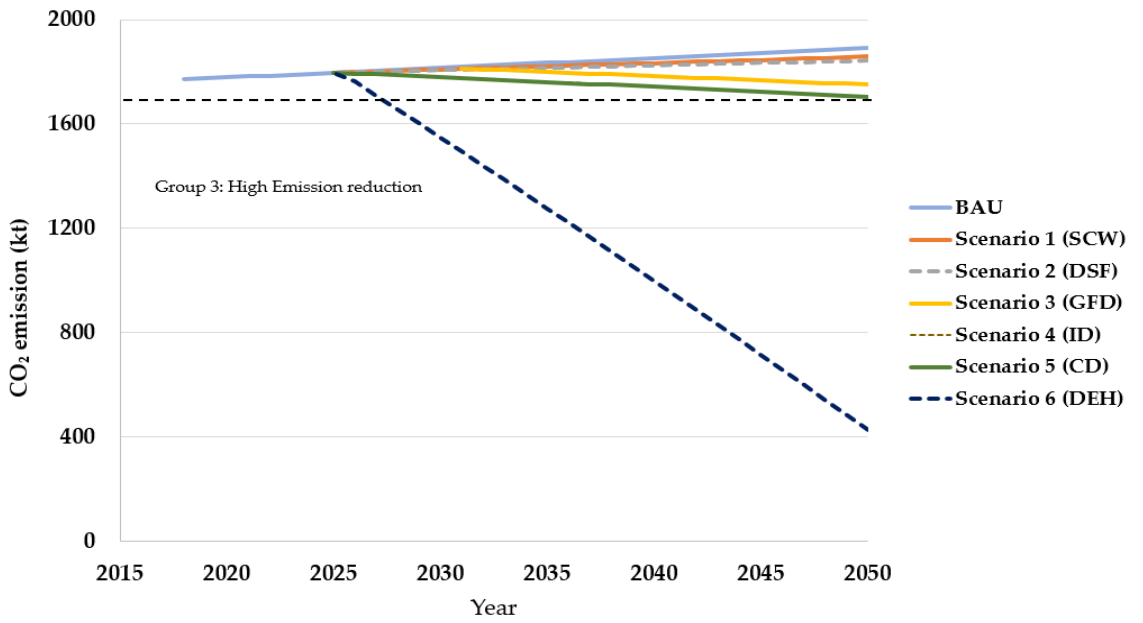
Figure 10. Projection of CO 2 emission by alternative scenarios without DEH (direct electric heating) technology.